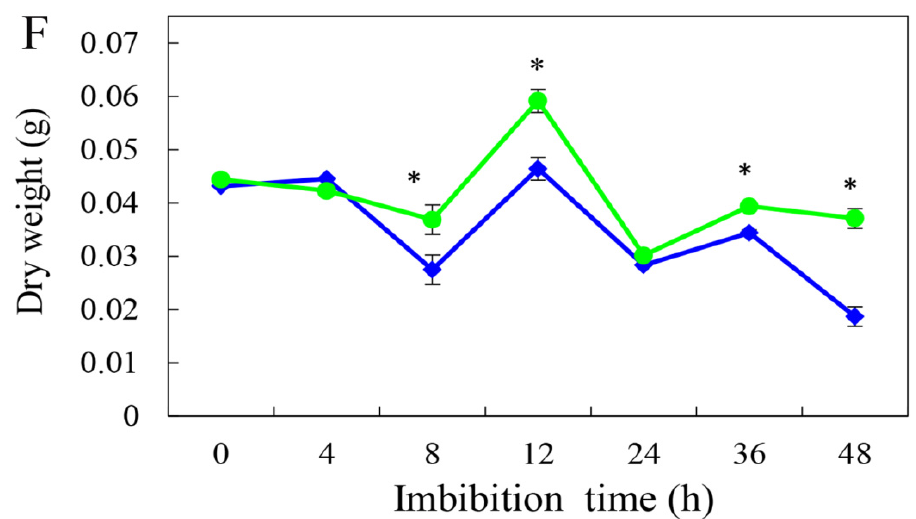
Figure 2. Changes in germination rate ( A ), germ length ( B ), germination index ( C ), vitality index ( D ), fresh weight ( E ), and dry weight ( F ) in cucumber with or without 75% HRW treatment during imbibition at 0, 4, 8, 12, 24, 36, and 48 h. The values (mean ± standard error (SE)) are the average of three independent experiments (n = 3). The asterisks denote Turkey–Kramer ′ s t -test significance under different treatments at the same time: * p < 0.05, h: hours, HRW: hydrogen-rich water.